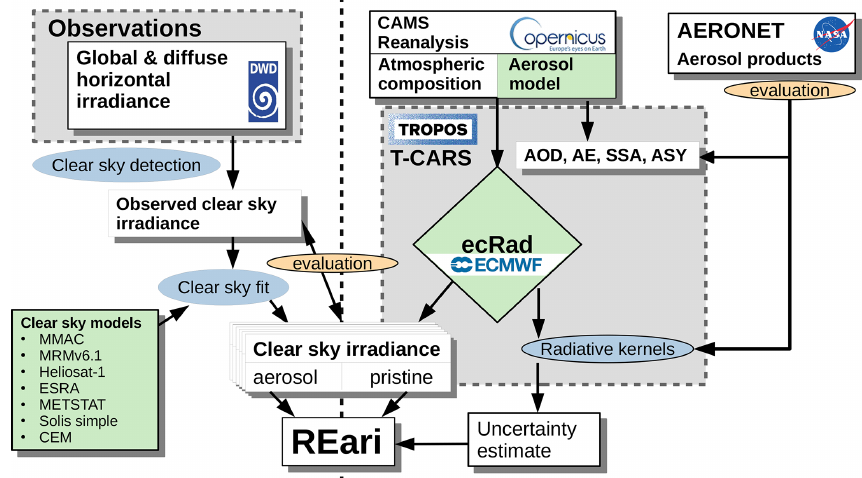
Figure 1. Schematic view of the analysis conducted in this study. Datasets are shown as white boxes, methods as blue ellipses and models in green. The study involves clear-sky detection (see Sect. 3.1), clear-sky fitting (see Sect. 3.2), the T–CARS setup (see Sect. 3.3), and a method utilizing radiative kernels to analyse the sensitivity and estimate the uncertainty of the REari simulation (see Sect.